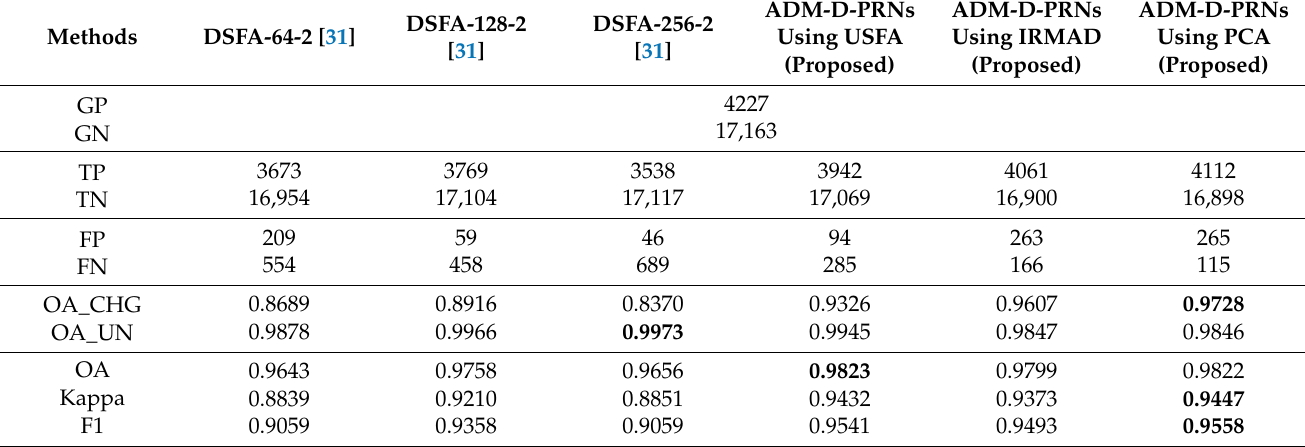
Table 3. Alteration detection results of dataset ‘Taizhou’ using